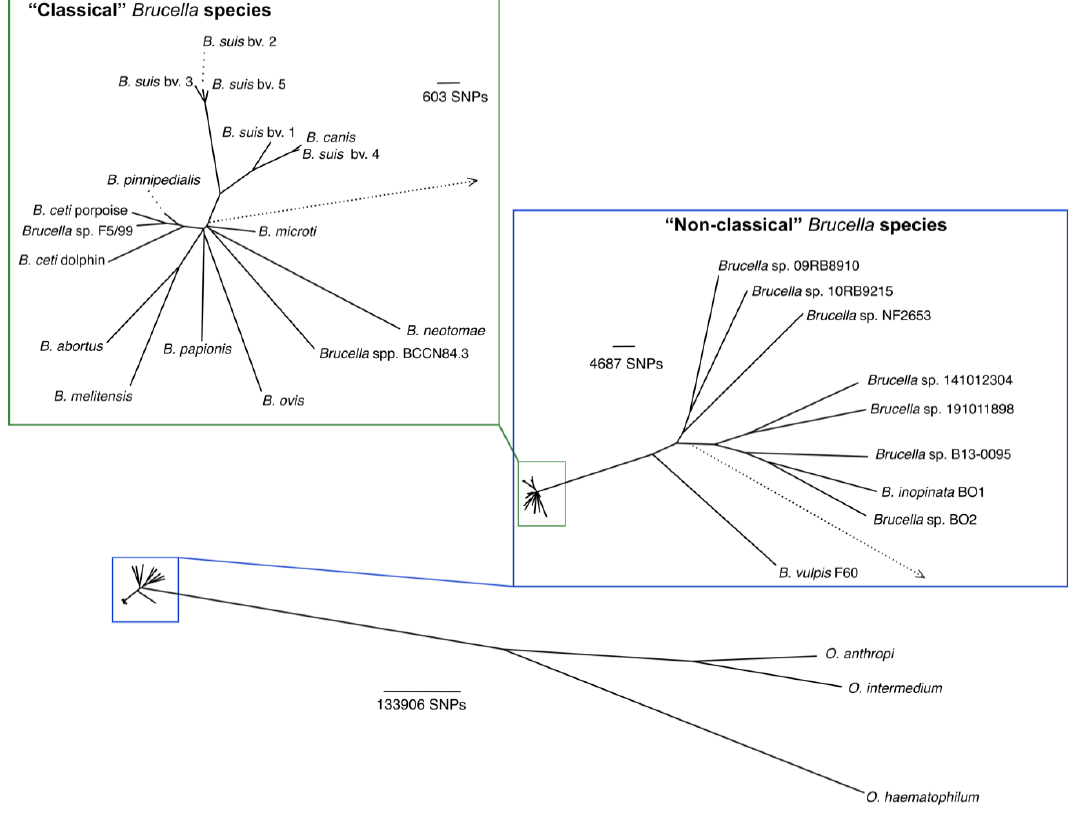
Figure 2. Phylogenetic relationship of “classical” and “non-classical” Brucella species and Ochrobactrum sp. based on 669529 SNPs. Segments of the tree were magnified to increase resolution. The SNPs scale is next to each magnified region. The dotted arrow represents the branch linking the magnified regions to the whole tree. A blue square highlights all Brucella species; the “classical” species are within the up left square. Modified from [77]. In Table S1 are the details of the strains and sequences used for the analysis.